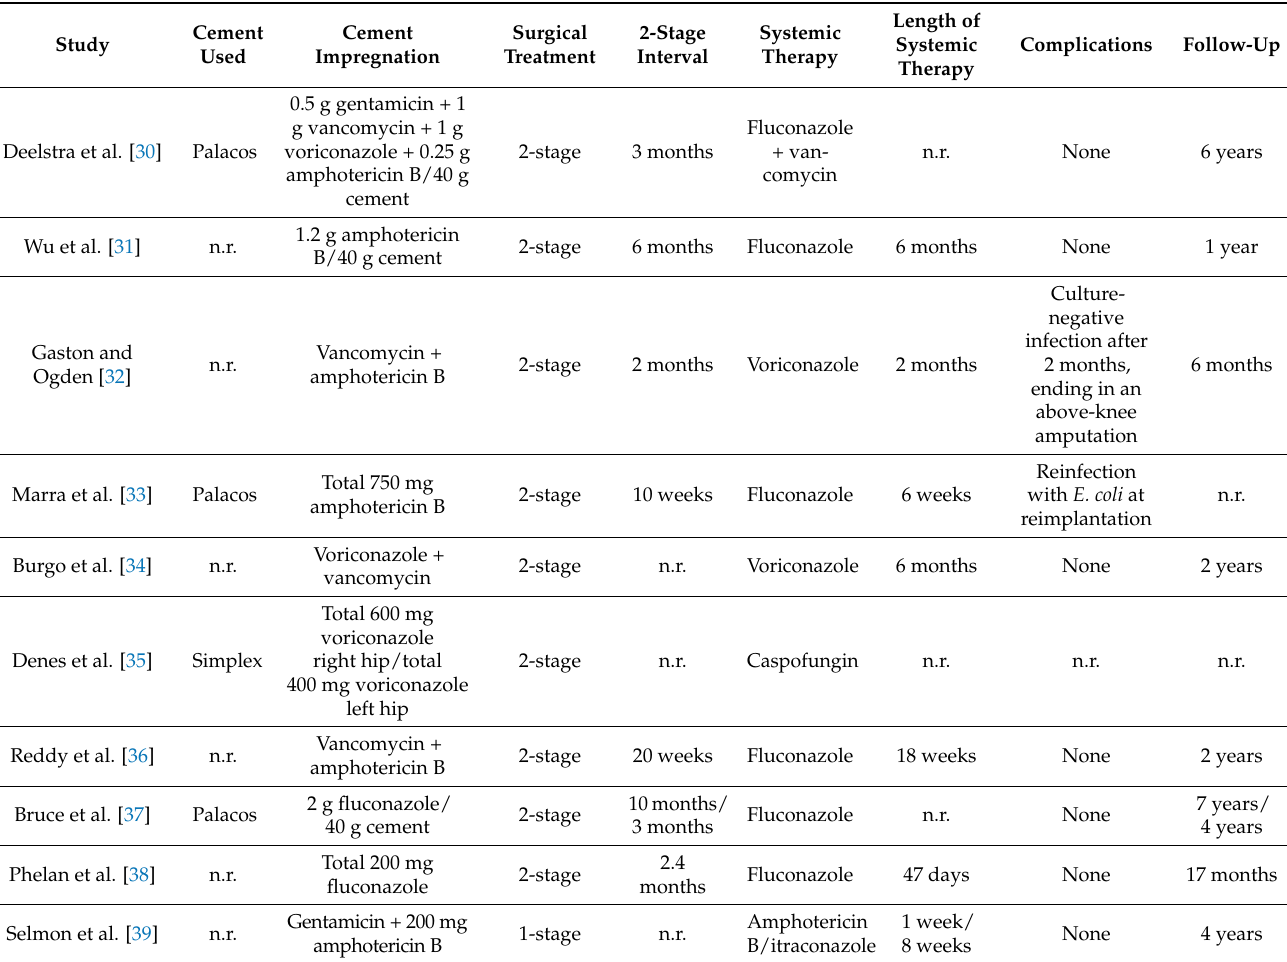
Table 2. Data about the use of antifungal-loaded acrylic bone cement and treatment